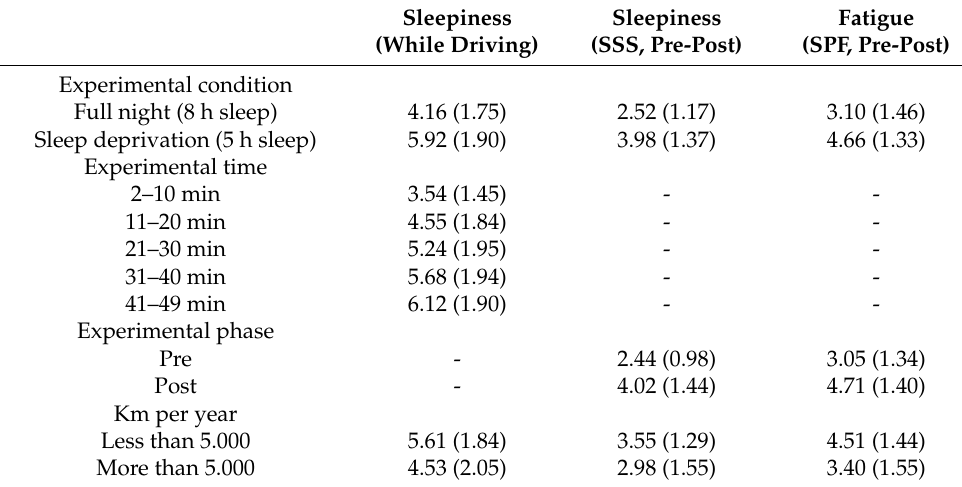
Table 2. Mean and standard deviation (between brackets) of the three subjective measures considered (range from 0 to 10, with 10 = maximum intensity), divided by: experimental condition (full sleep night with 8 h sleep; sleep deprivation with 5 h sleep), experimental time (only sleepiness while driving, five 10 min blocks), experimental phase (SSS and SPF, before and after the driving sessions), and kilometers travelled per year (more or less than